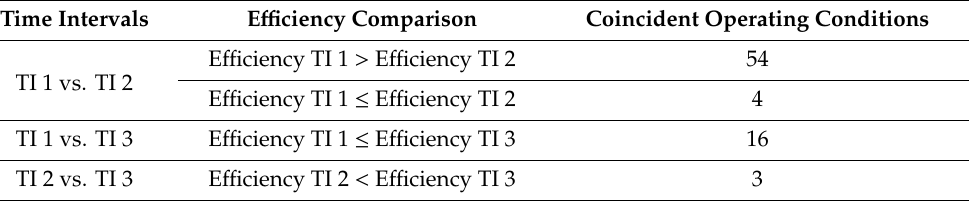
Table 10. E ffi ciency comparison among the identified time intervals.